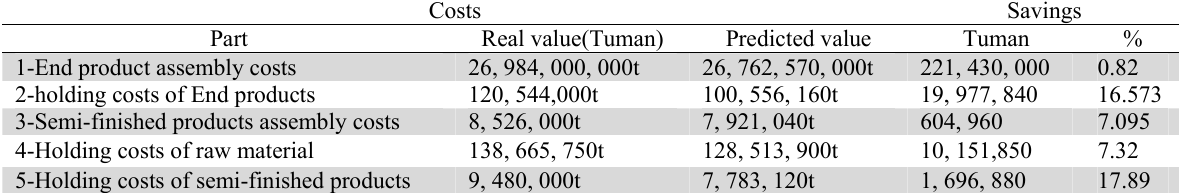
Costs and Savings ( PEUGEOT 405GLI )